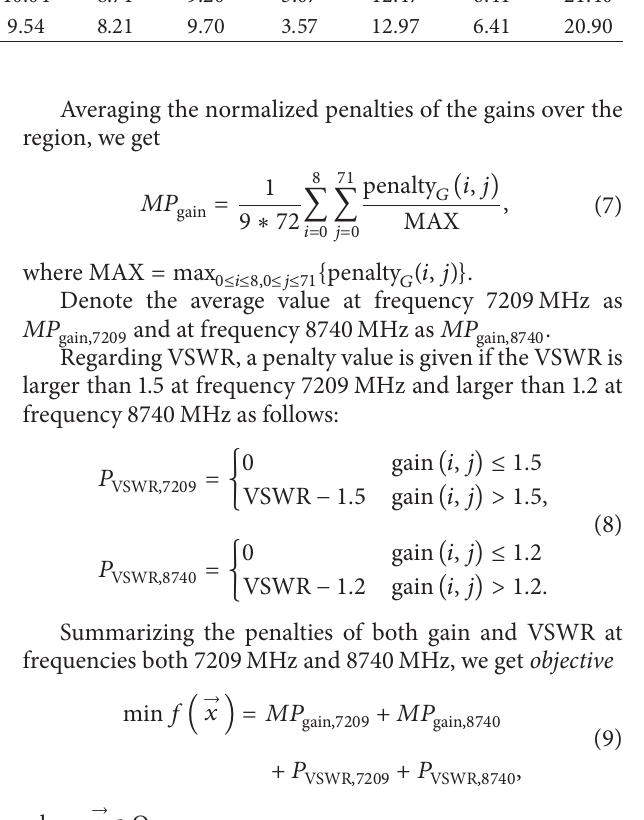
Table 6: The code of the geometric structure in mm of the rough antenna and the optimized new one for ST5 satellite. 1 ( 𝑧 0 )